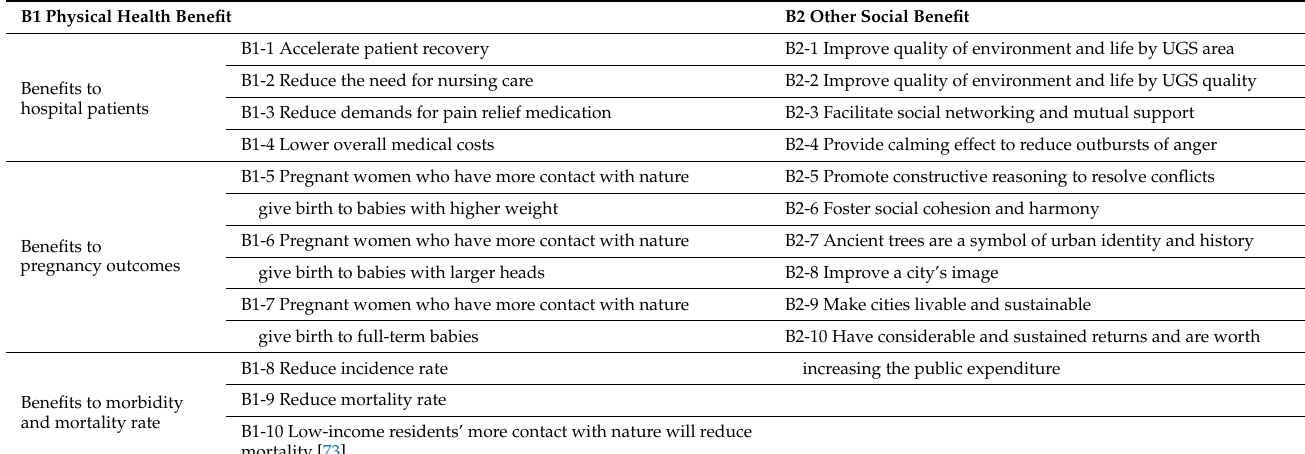
Table 1. Classification of UGS ’ social benefits into two main categories in the questionnaire survey.